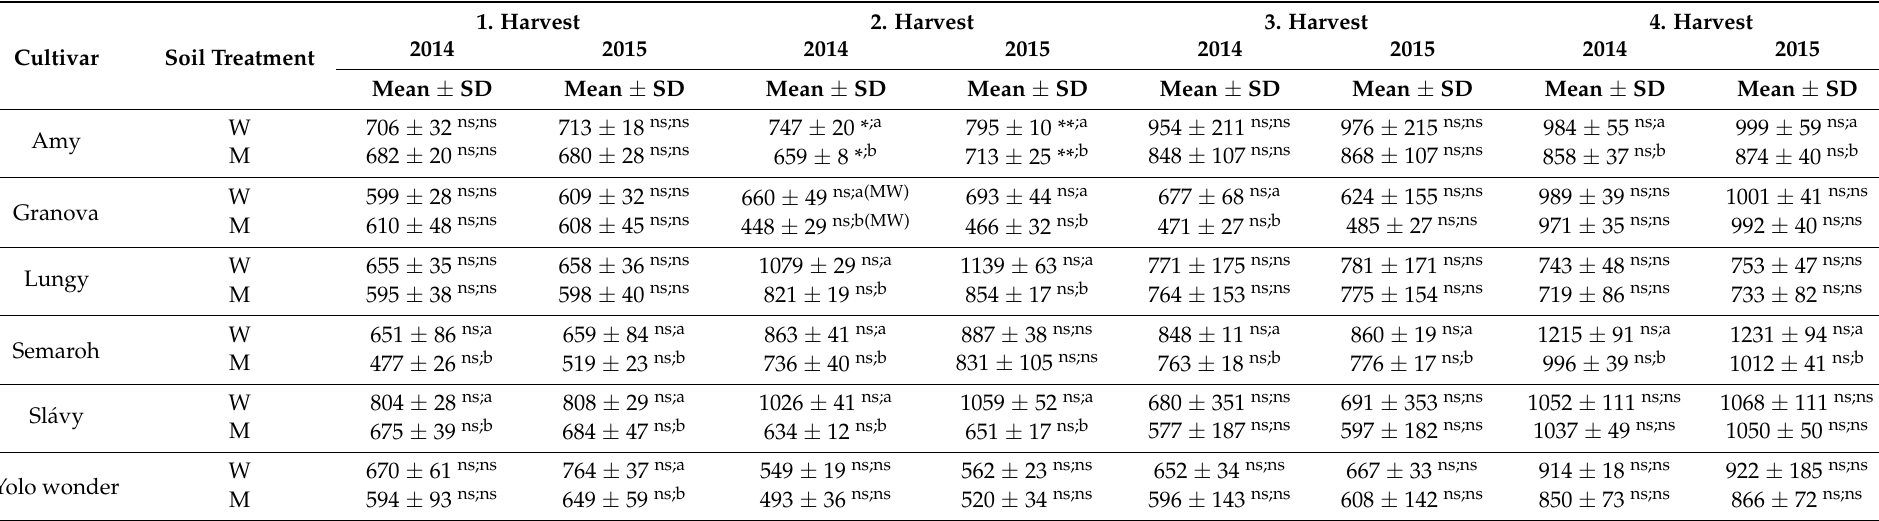
Table 4. Vitamin C content according to collections, variants and years (mg · kg − 1